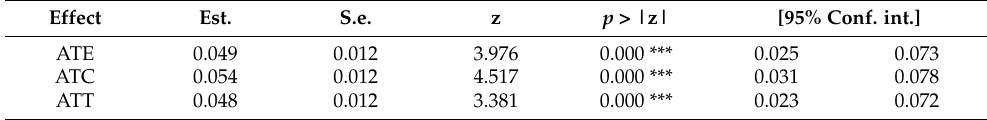
Table 3. Test for causal effects after matching.